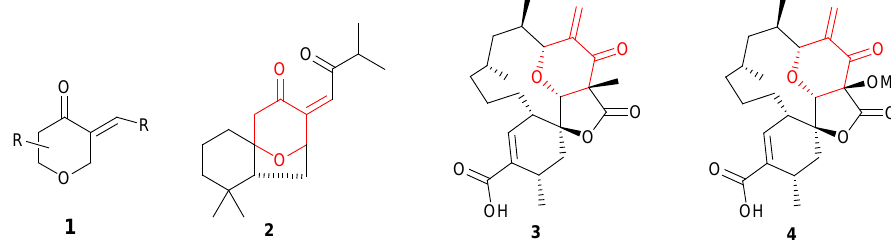
Figure 1. Natural compounds containing 3 - alkylidenetetrahydropyran -4- one skeleton .